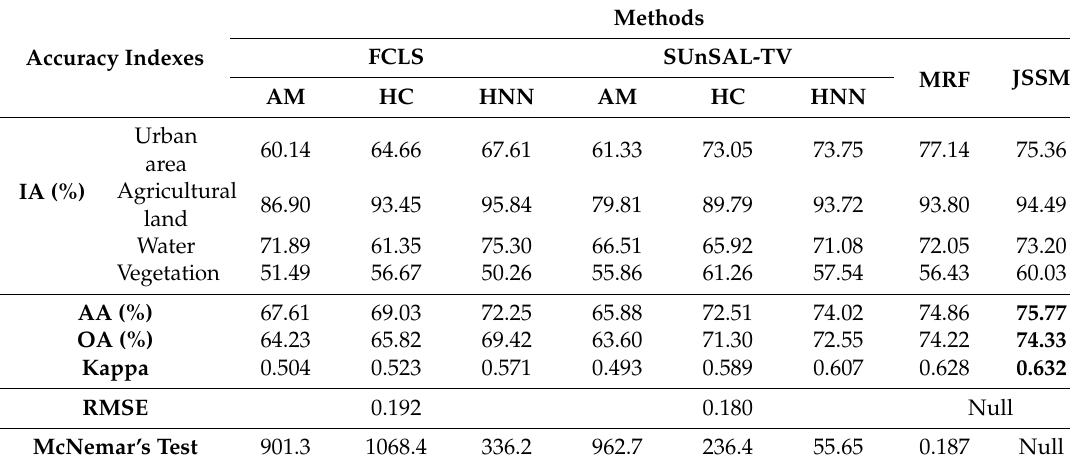
Table 1. Sub-pixel mapping results for the HJ-1A